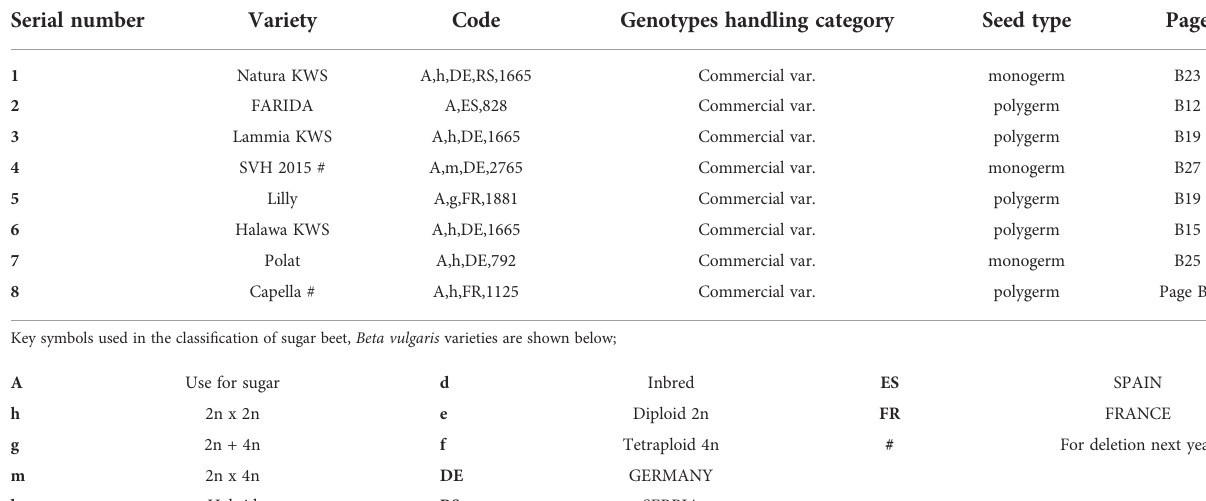
TABLE 1 Description of sugar beet (Beta vulgaris saccharifera) varieties assessed for their resistance to the root-knot nematode, Meloidogyne incognita , and their seed types (monogerm or polygerm) according to the list of varieties eligible for seed certi fi cation (OECD, 2019). Serial